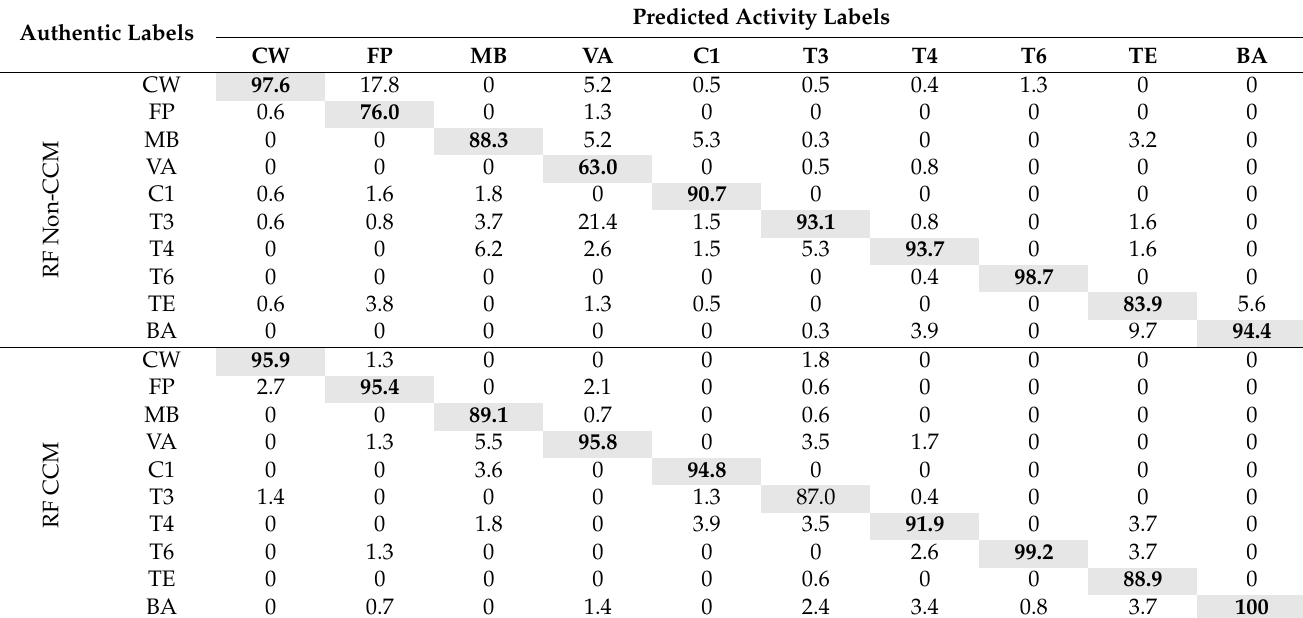
Table 8. The classification accuracies of the 10 PA patterns comparison between the RF with CCM and the RF with non-CCM